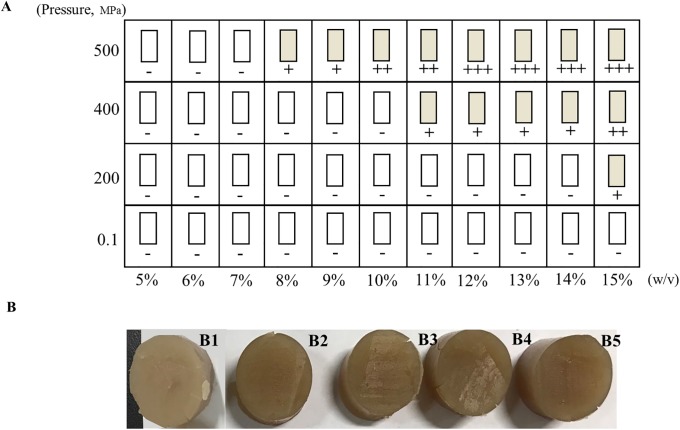
The states of β-Glucan (OG) gels prepared with varying concentrations under different pressures.(A) The states of β-Glucan (OG) gels. The solution state designated with a white rectangle, the gel state designated with a yellow rectangle, "-" means no gel; "+" means that the soft gel with coarser and less-compacted apparent; "++" means glossier and smoother gel; "+++" means that the gel with much smoother and more compact. (B) The photograph of β-Glucan (OG) gels with varying concentrations under 400MPa. B1-B5, total concentrations from 11% (w/v) to 15%(w/v).